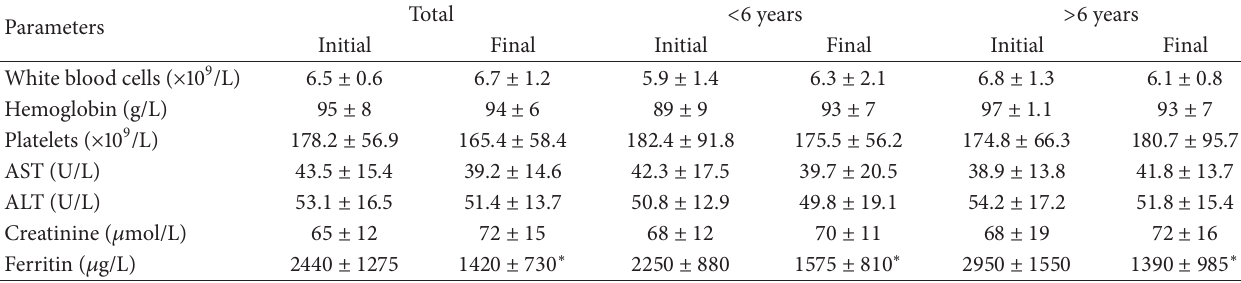
Table 2: Hematological and biochemical markers during treatment with oral solution of deferiprone (Ferriprox 100mg/mL) in nine children (4 under 6 years, 5 above 6 years) with transfusion dependent